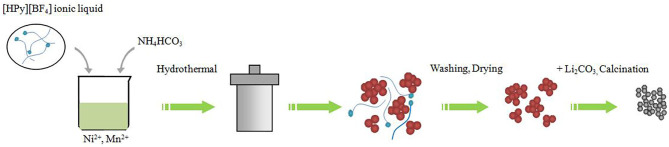
Illustration of the formation of 0.5Li2MnO3·0.5LiNi0.5Mn0.5O2 nanoparticles with ionic-liquid-assisted hydrothermal method.